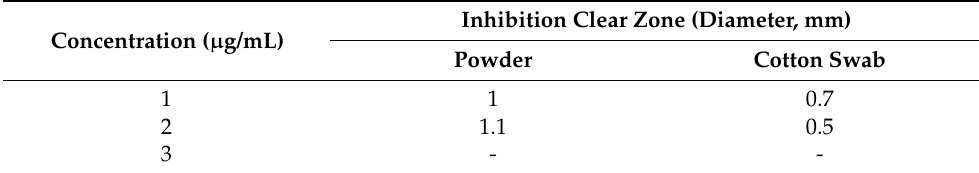
Table 1. Comparison of inhibition zone estimated from Figure 4.